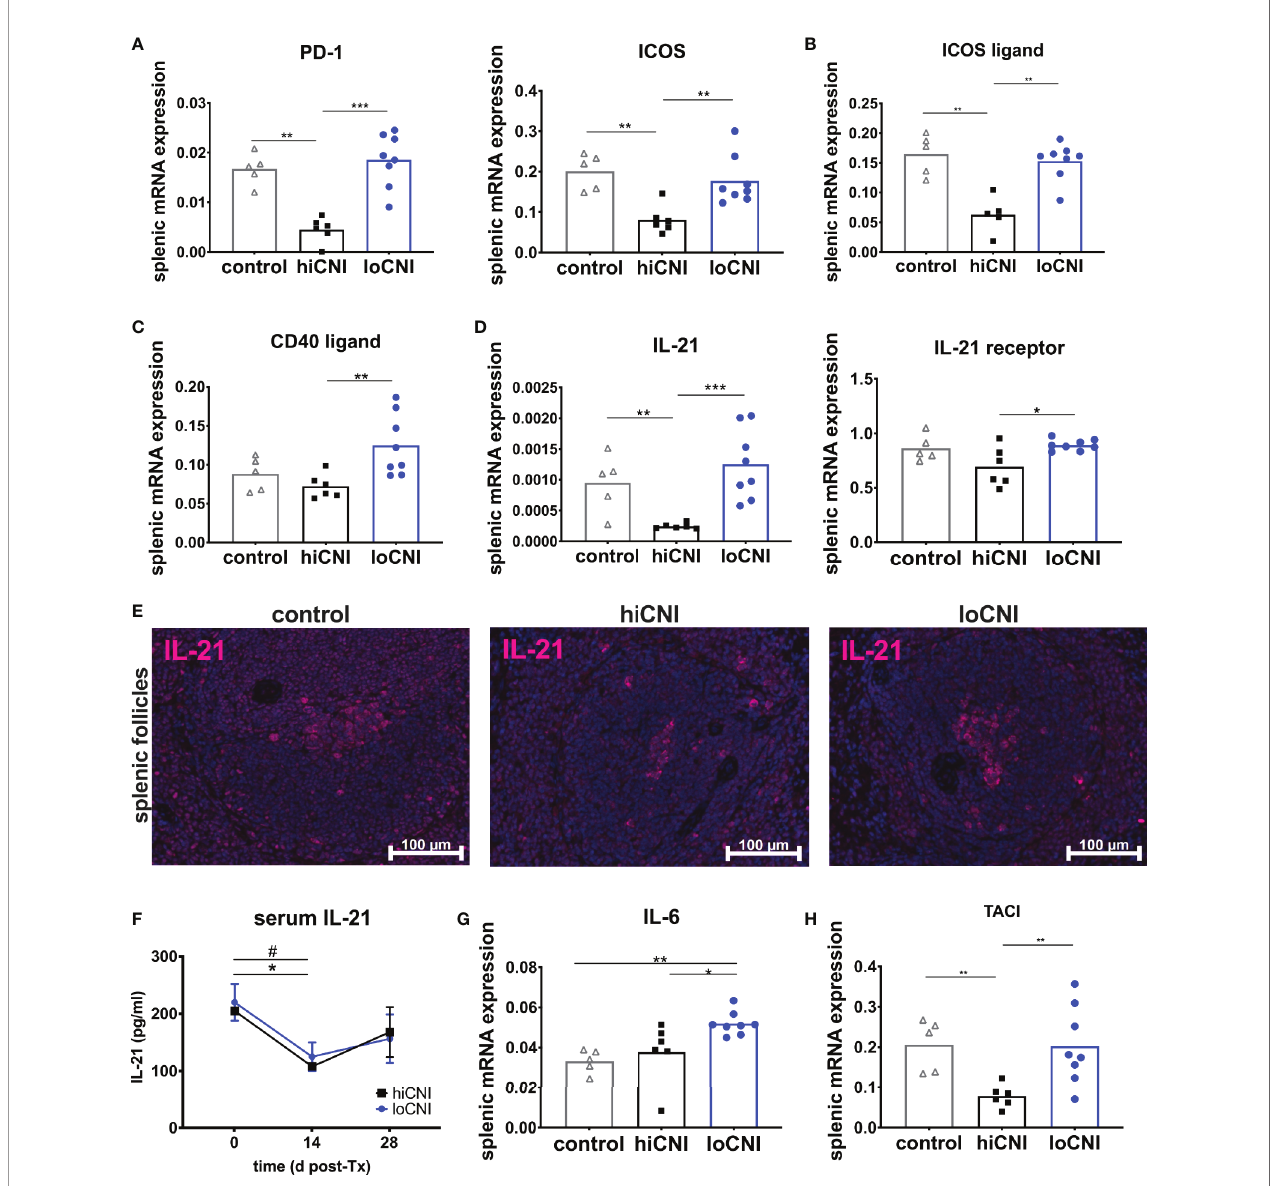
FIGURE 5 | Markers associated with activation and function of T follicular helper cells. (A) splenic mRNA expression of PD-1 and ICOS, (B) ICOS ligand (C) CD40 ligand and (D) IL-21 and IL-21 receptor. From controls (n=5), hiCNI (n=6) and loCNI (n=8), (E) representative immuno fl uorescent staining of IL-21 within splenic follicles. (F) Serum IL-21 concentrations of hiCNI and loCNI at d0 (hiCNI n=3, loCNI n=3), d14 (hiCNI n=2, loCNI n=8) and d28 (hiCNI n=6, loCNI n=8) post-Ktx. Splenic mRNA expression of IL-6 (G) and TACI (H) from controls (n=5), hiCNI (n=6) and loCNI (n=8). Expression of mRNA was normalized to house-keeping gene HPRT and expressed as delta CT (AU). Data is shown as mean and individual data points; statistical signi fi cance is denoted as *p ≤ 0.05, **p<0.01 and ***p<0.001. In (F) , # p ≤ 0.05 for loCNI, *p ≤ 0.05 for